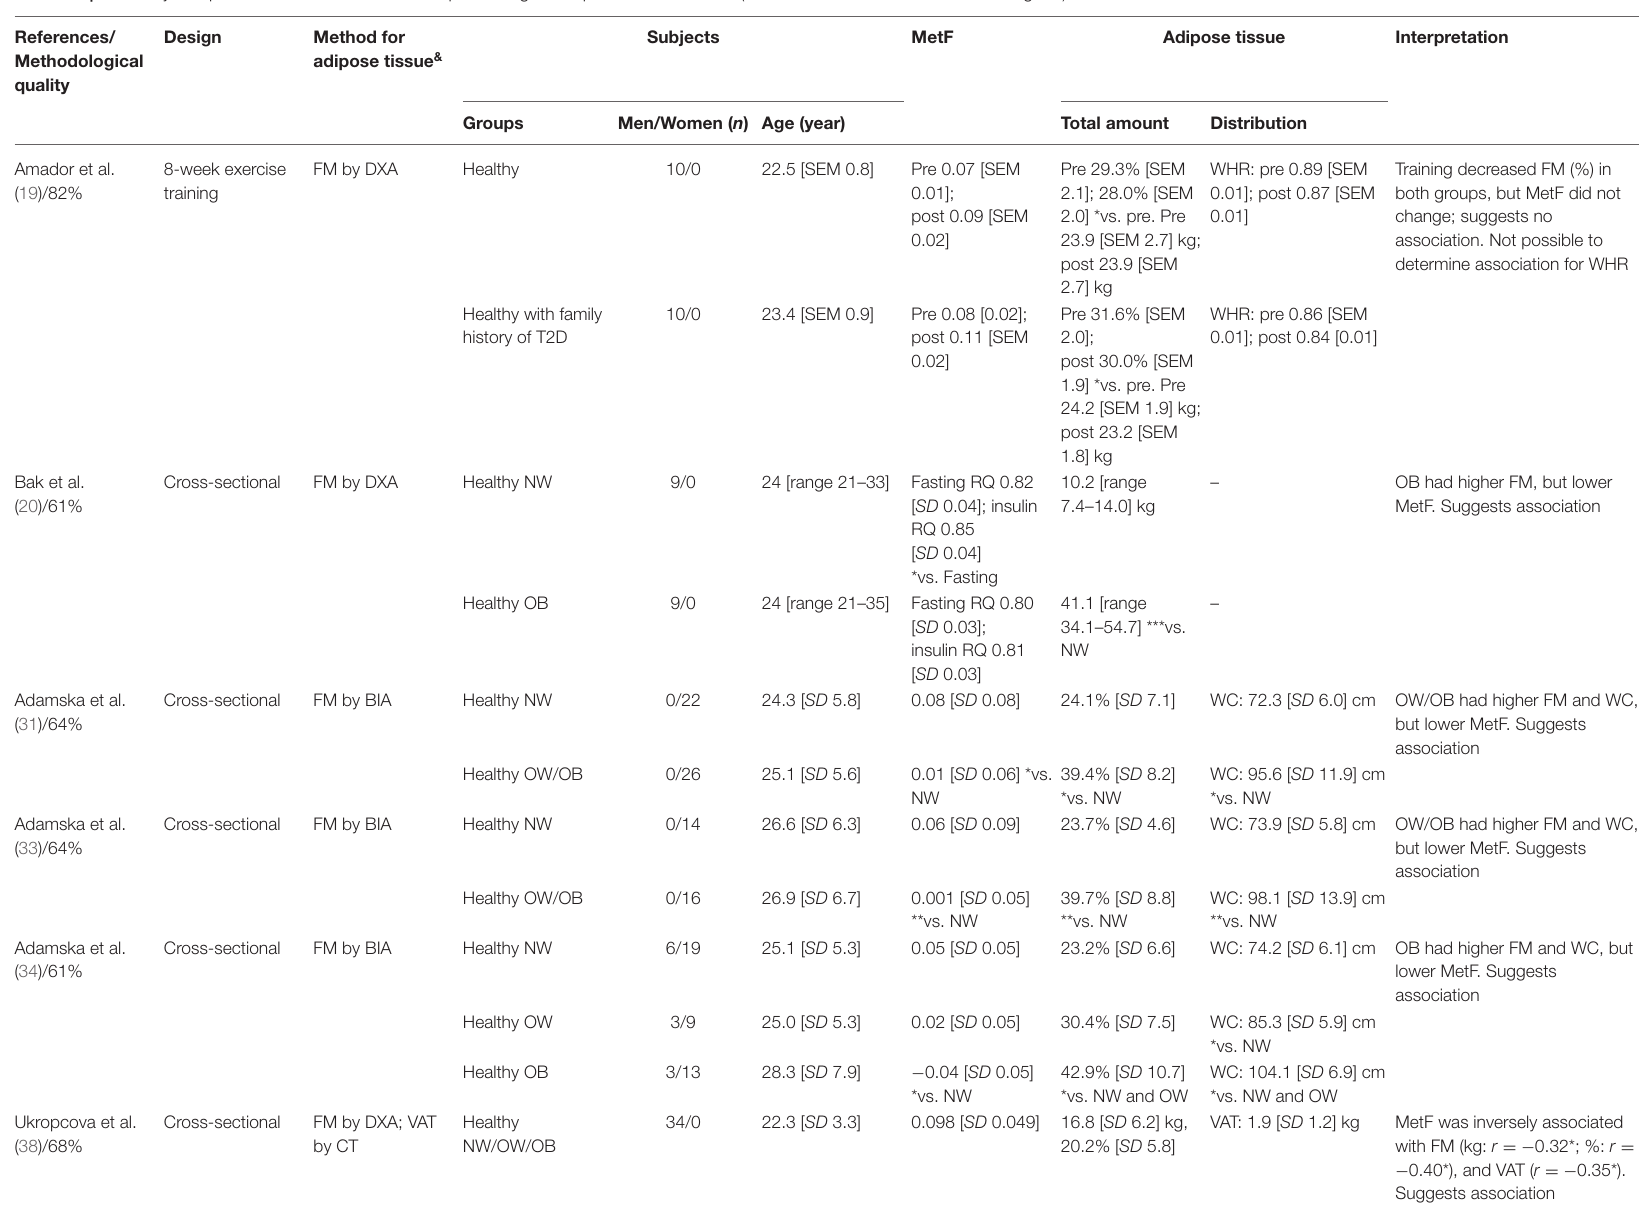
TABLE 1 | Summary of reports that measured MetF in response to glucose plus insulin infusions ( 1 RQ = insulin-stimulated RQ – fasting